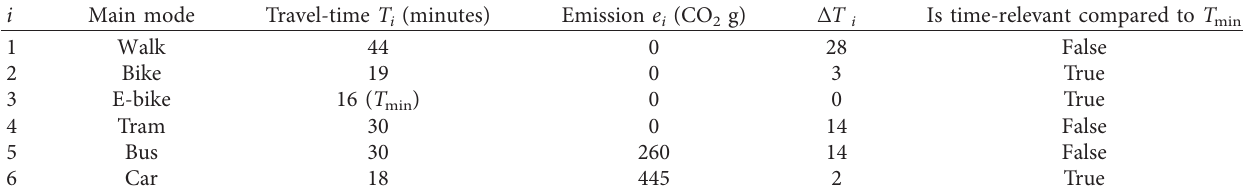
Table 3: An execution of the algorithm for a trip whose origin is “Sturenkatu 9” and destination is “Laivurinkatu 39.” i